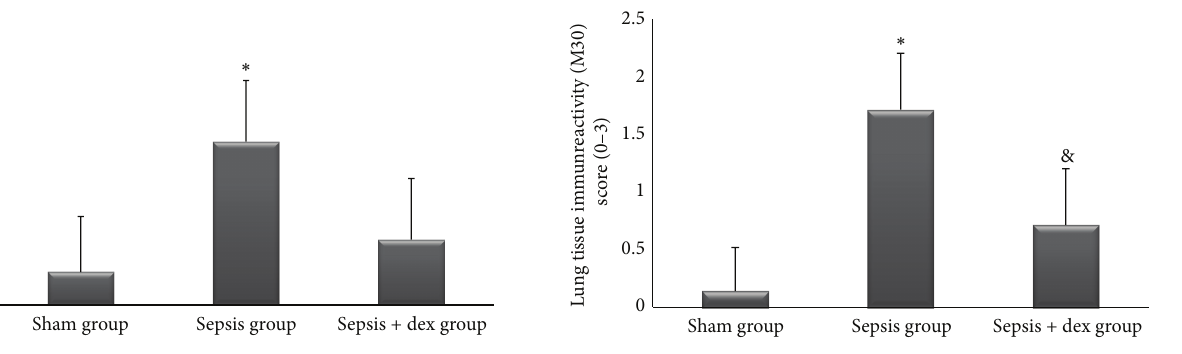
Figure 6: Histological kidney injury scores in experimental groups. ∗ 𝑃 < 0.05 compared with sham and sepsis + dex groups.